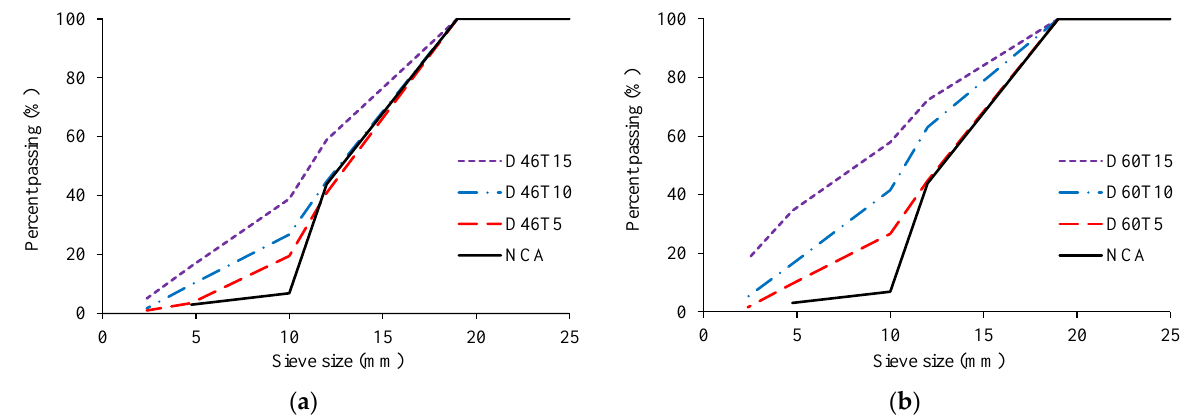
Figure 9. Influence of LA abrasion duration on NCA by balls of: ( a ) standard size (46-mm diameter); and ( b ) 60-mm diameter (Legends D p : p mm dia balls, T q : q minutes of LA abrasion duration).